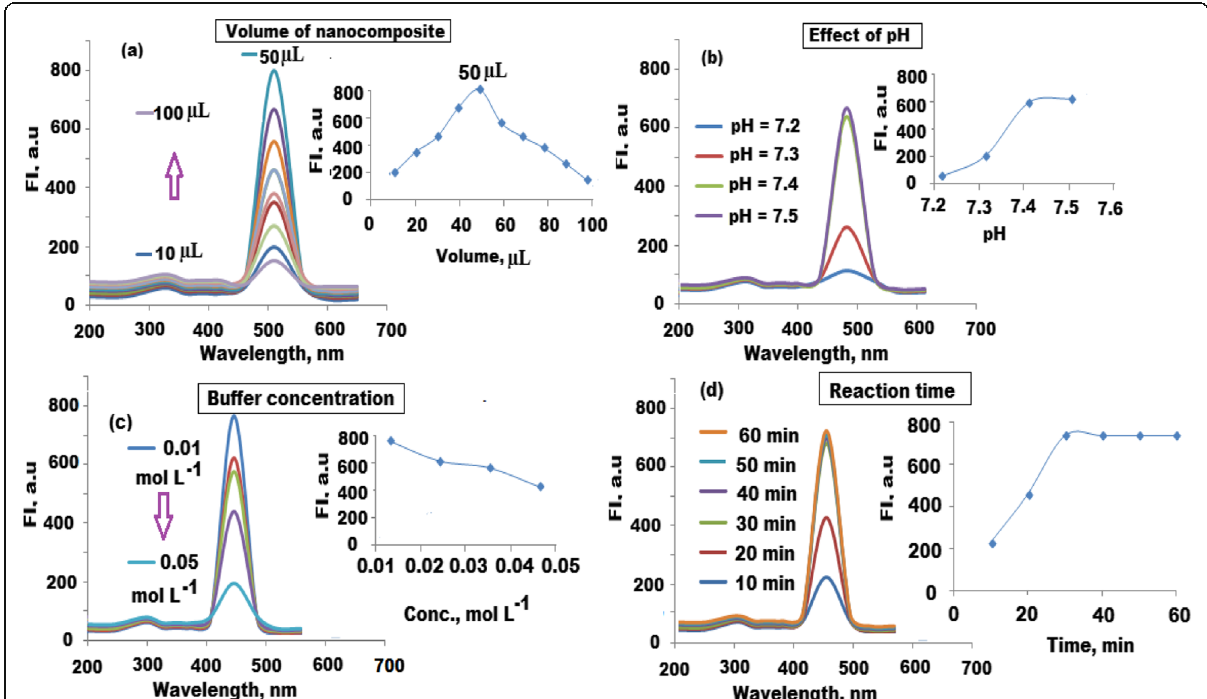
Fig. 9 Optimization of fluorescence determination of CYFRA 21-1 antigen at λ ex = 470 and λ em = 520 nm. a Effect of added immobilized CQDs/ ZnO-BM 19.21 nanocomposite, b effect of phosphate buffer saline of pH range 7.3 – 7.5, c effect of buffer concentration using PBS in the concentration range of 0.01 – 0.05 mol L − 1 , and d effect of immunoreaction time using 10 – 60